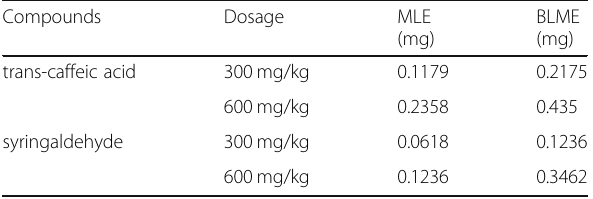
Table 2 The total quantities of two marker compounds in injected doses of mulberry leaf extract (MLE) and bioconverted mulberry leaf extract (BMLE) in animal experiments Compounds